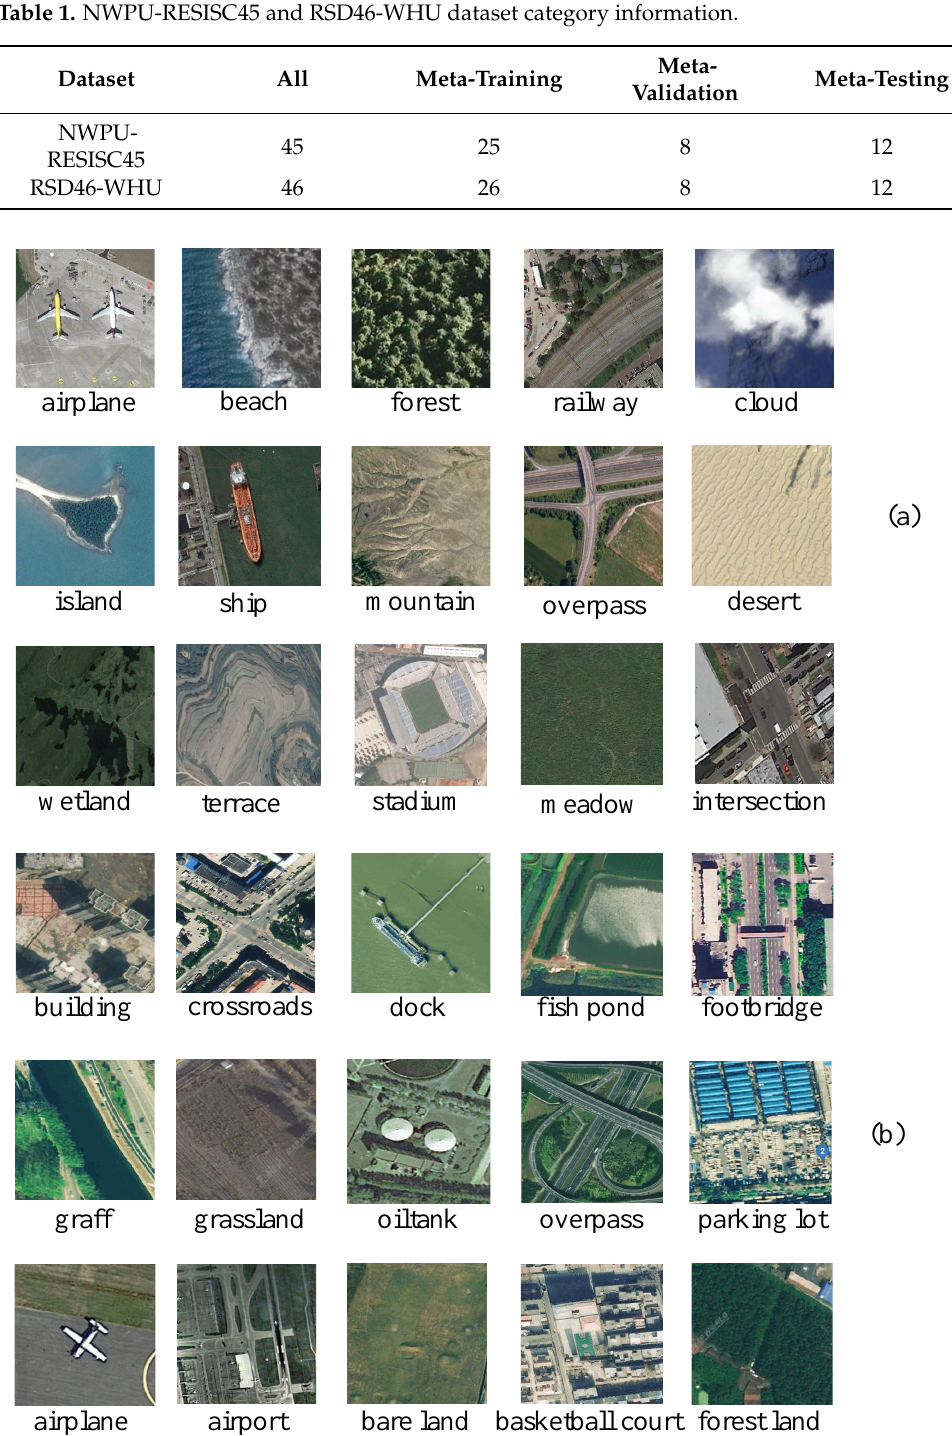
Figure 3. Samples from different datasets. ( a ) NWPU-RESISC45, ( b )